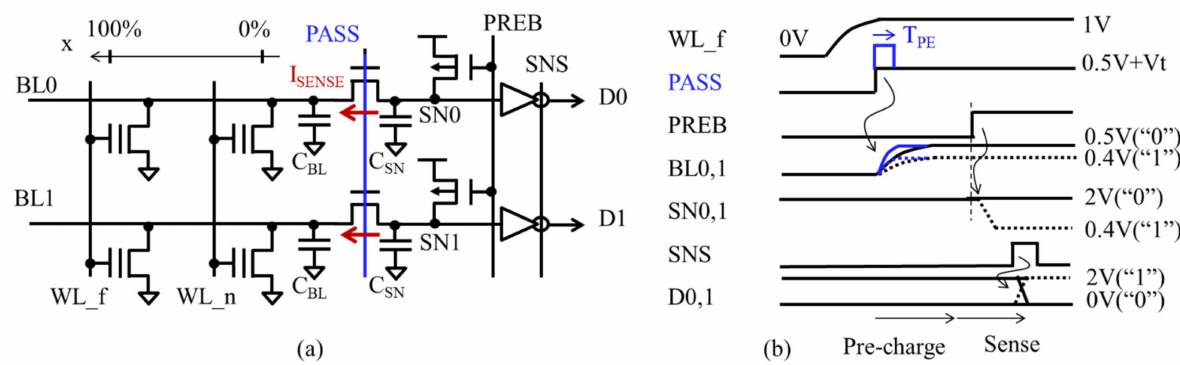
Figure 1. ( a ) BL path of NAND flash. ( b ) Signal waveform for data